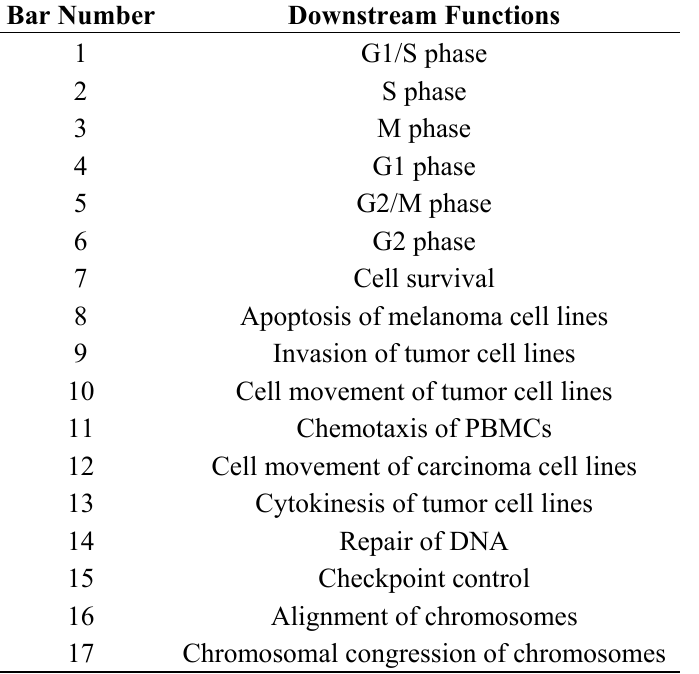
Table 3. Specification of the downstream functions seen in Figure 7.